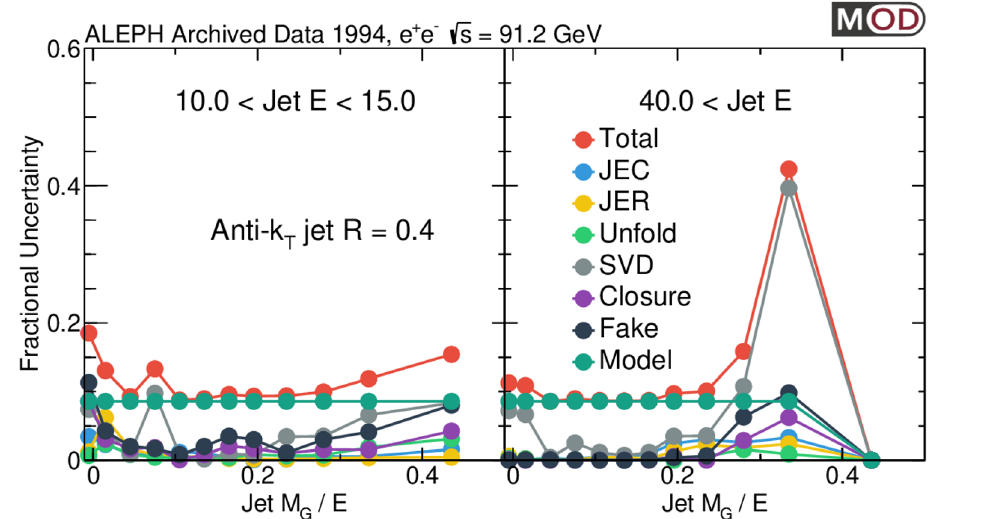
Figure 10 . Summary of the size of relative systematic uncertainty from different sources for M G /E , in bins of jet E from 10–15 GeV (left panel) to above 40 GeV (right panel).